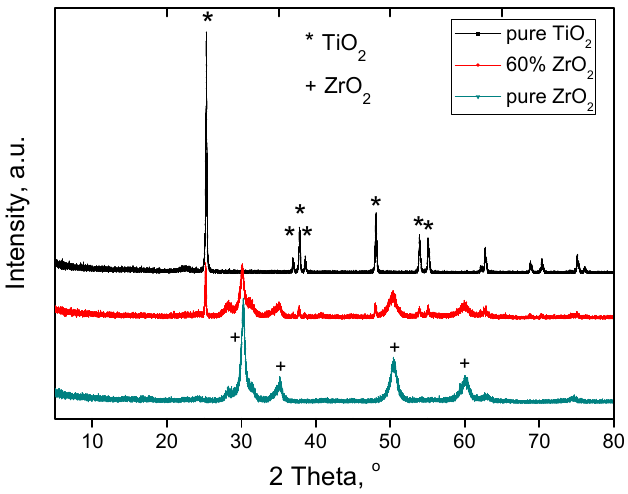
Figure 1. XRD patterns of 60% ZrO 2 -TiO 2 pure ZrO 2 and pure TiO 2 catalyst.